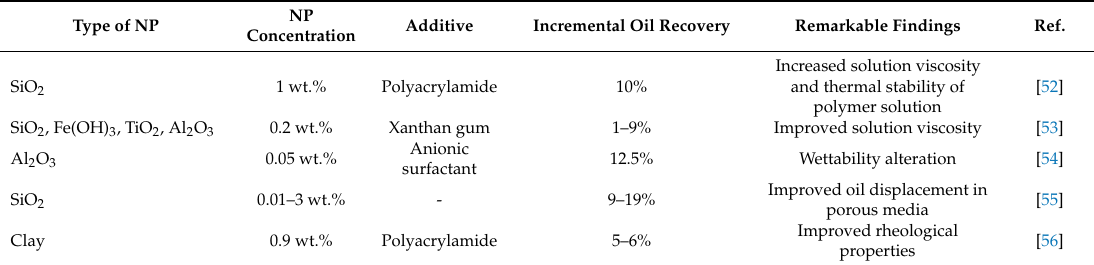
Table 1. A summary of types and concentrations of NPs used in